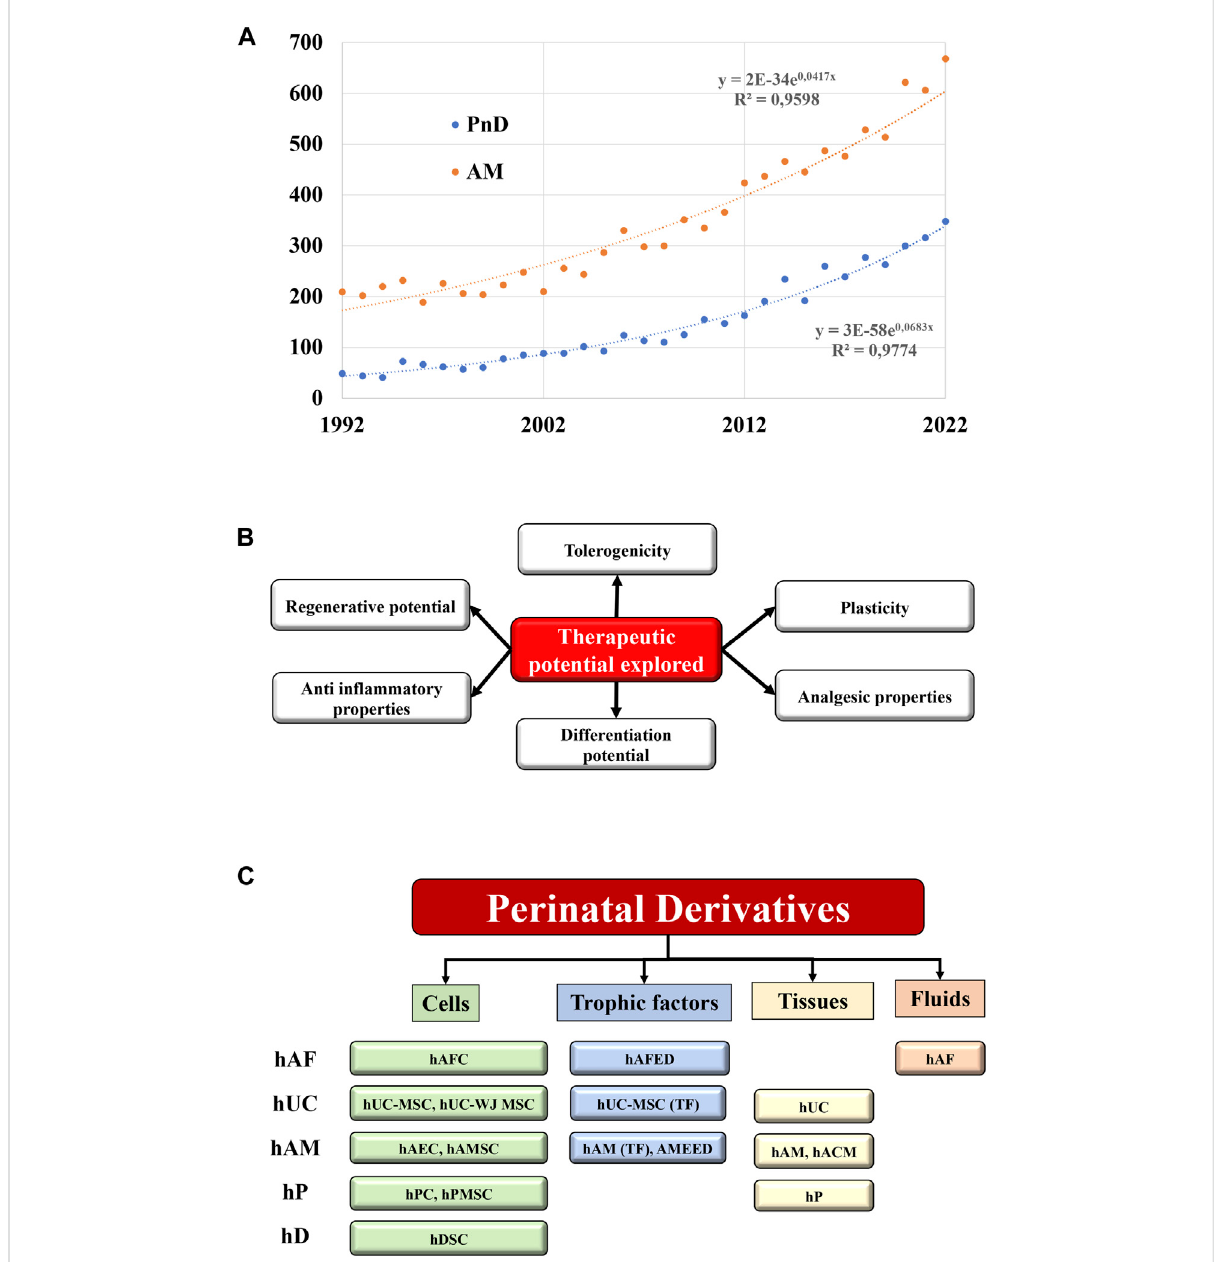
FIGURE 1 StateoftheartofthePerinatalderivatives. (A) Representstheexponentialincreasewithinthelast3 decadesoftheannualnumberofreferences indexed in pubmed.gov site with the keywords “ perinatal derivatives ” and “ amniotic membrane ” . The numbers of references doubled every 10 years for the PnD, and every 17 years for the amniotic membranes. (B) Therapeutic potential of PnD. (C) Different types of PnD utilized in the clinical trials (cells, trophic factors, tissues, fl uids) according the different sources of PnD. Abbreviations: hP: human placenta; hUC: human umbilical cord; hAM: human amniotic membrane; hAF: human amniotic fl uid; hD: human decidua; TF: trophic factors; hPC: human placental cells; hPMSC: human placental mesenchymal stromal cells; WJ: Wharton ’ s jelly; MSC: mesenchymal stromal cells; hACM: amnio-chorionic membrane; hAEC: human amnioticepithelialcells;hAMC:humanamniotic membranecells;AMEED: amnioticmembraneextracteyedrops;hAFC:humanamniotic fl